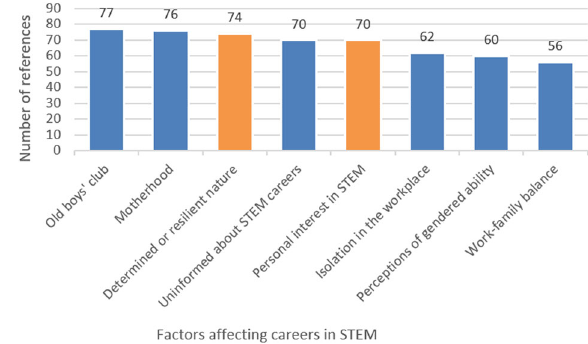
Fig. 1 Top 8 factors affecting participants ’ careers in STEM. Barriers are represented by the blue bars and enablers are represented by the orange bars. The number of references made to each of the barriers and enablers is noted above each